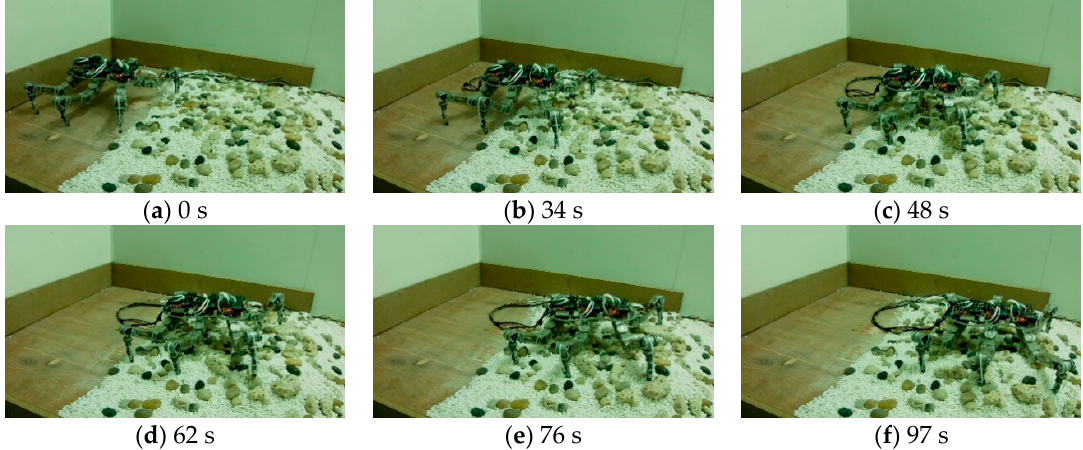
Figure 19. Posture control experiment on staged unstructured terrain.